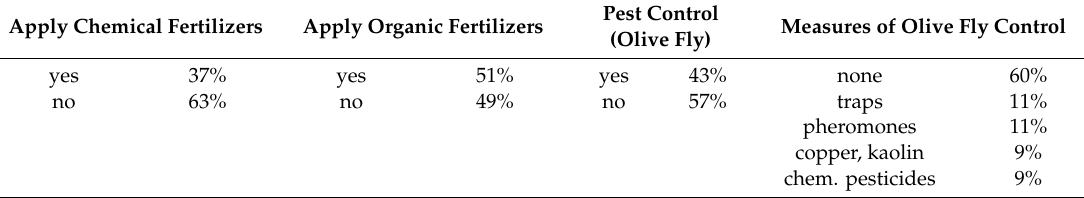
Table 7. Farming practices by hobby farmer samples ( n = 35); % refers to the total per item. Apply Chemical Fertilizers